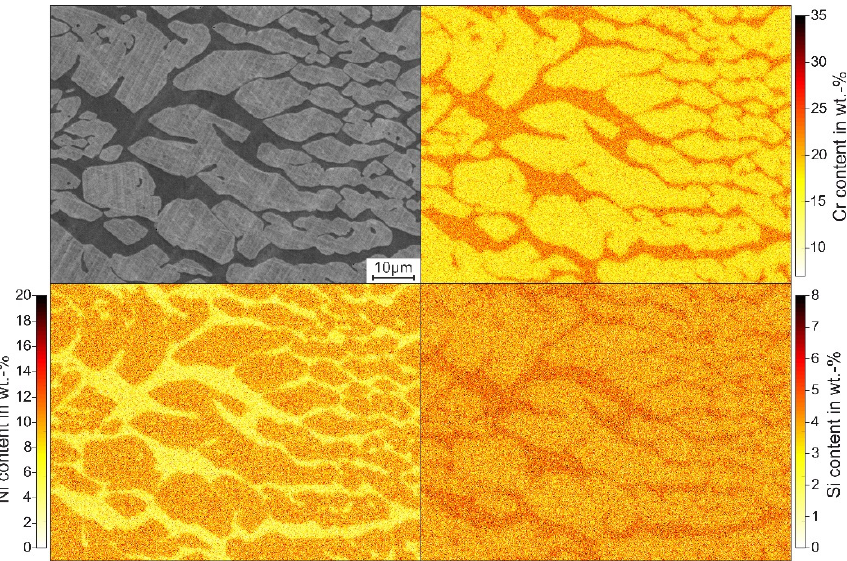
Figure 5. SEM ‐ BSE micrograph and the local element concentrations of Cr and Ni in the Figure 5. SEM-BSE micrograph and the local element concentrations of Cr and Ni in the X2CrNiW15- X2CrNiW15 ‐ 9 ‐ 5 steel. 9-5 steel.